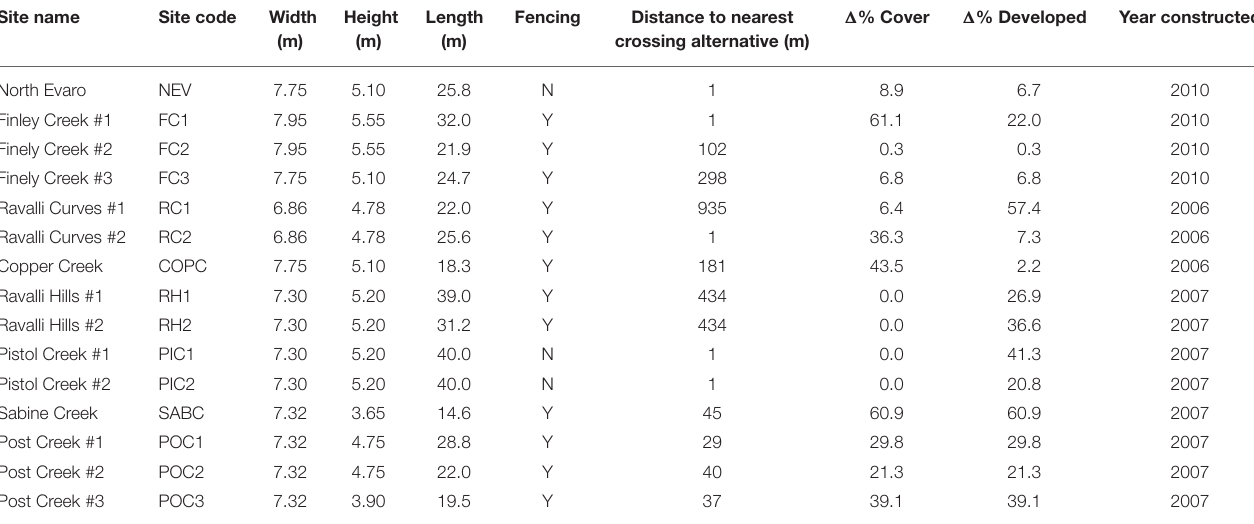
TABLE 1 | Structural and locational attributes of the elliptical, corrugated metal wildlife crossing structures monitored in the study including dimensions, presence of associated wildlife exclusion fencing, distance to nearest crossing alternatives*, percent difference in development and cover in surrounding habitat on either side of the road**, and year of